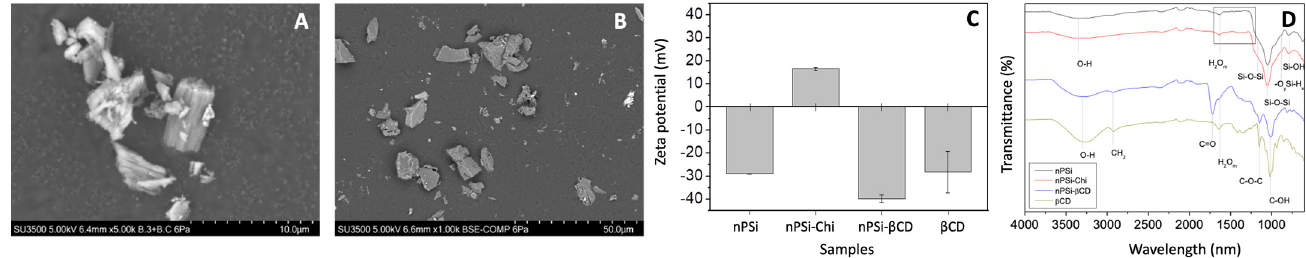
Figure 5. Monitoring of the synthesis process of nPSi- β CD composite microparticles: ( A ) Scanning electron microscope images (SEM) of samples nPSi, ( B) Scanning electron microscope images (SEM) of samples nPSi- β CD, ( C ) Zeta potential and ( D ) the magnification of ATR-FTIR spectra.